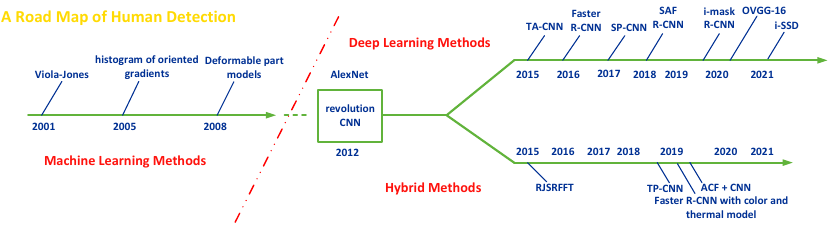
Figure 2. Human-detection